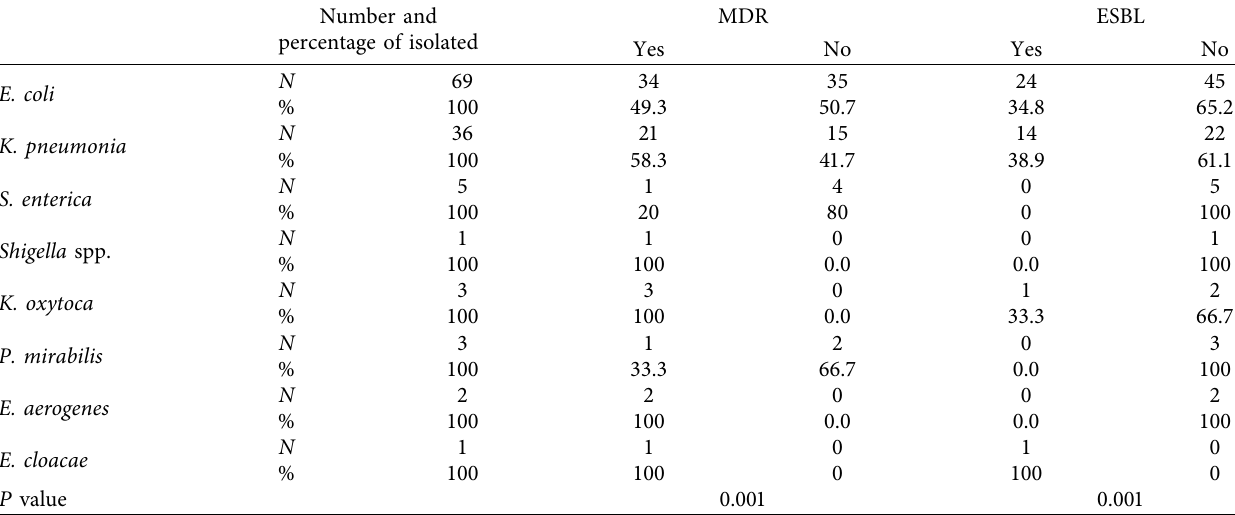
Table 3: The prevalence of MDR and ESBL among Enterobacteriaceae . Number and percentage of